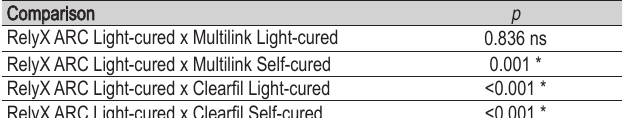
Table 4 - Dunnett`s test for comparison between the control group (RelyX ARC) and experimental